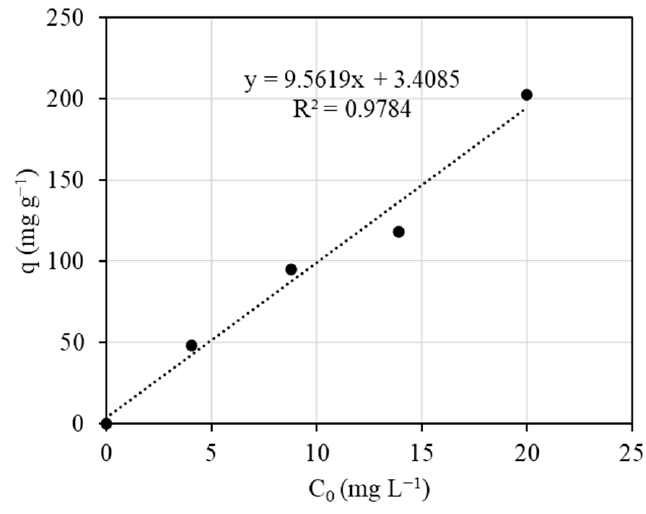
Figure 6. Dependence of the adsorption capacity of Spirulina on the initial metal concentration of Pb (II).